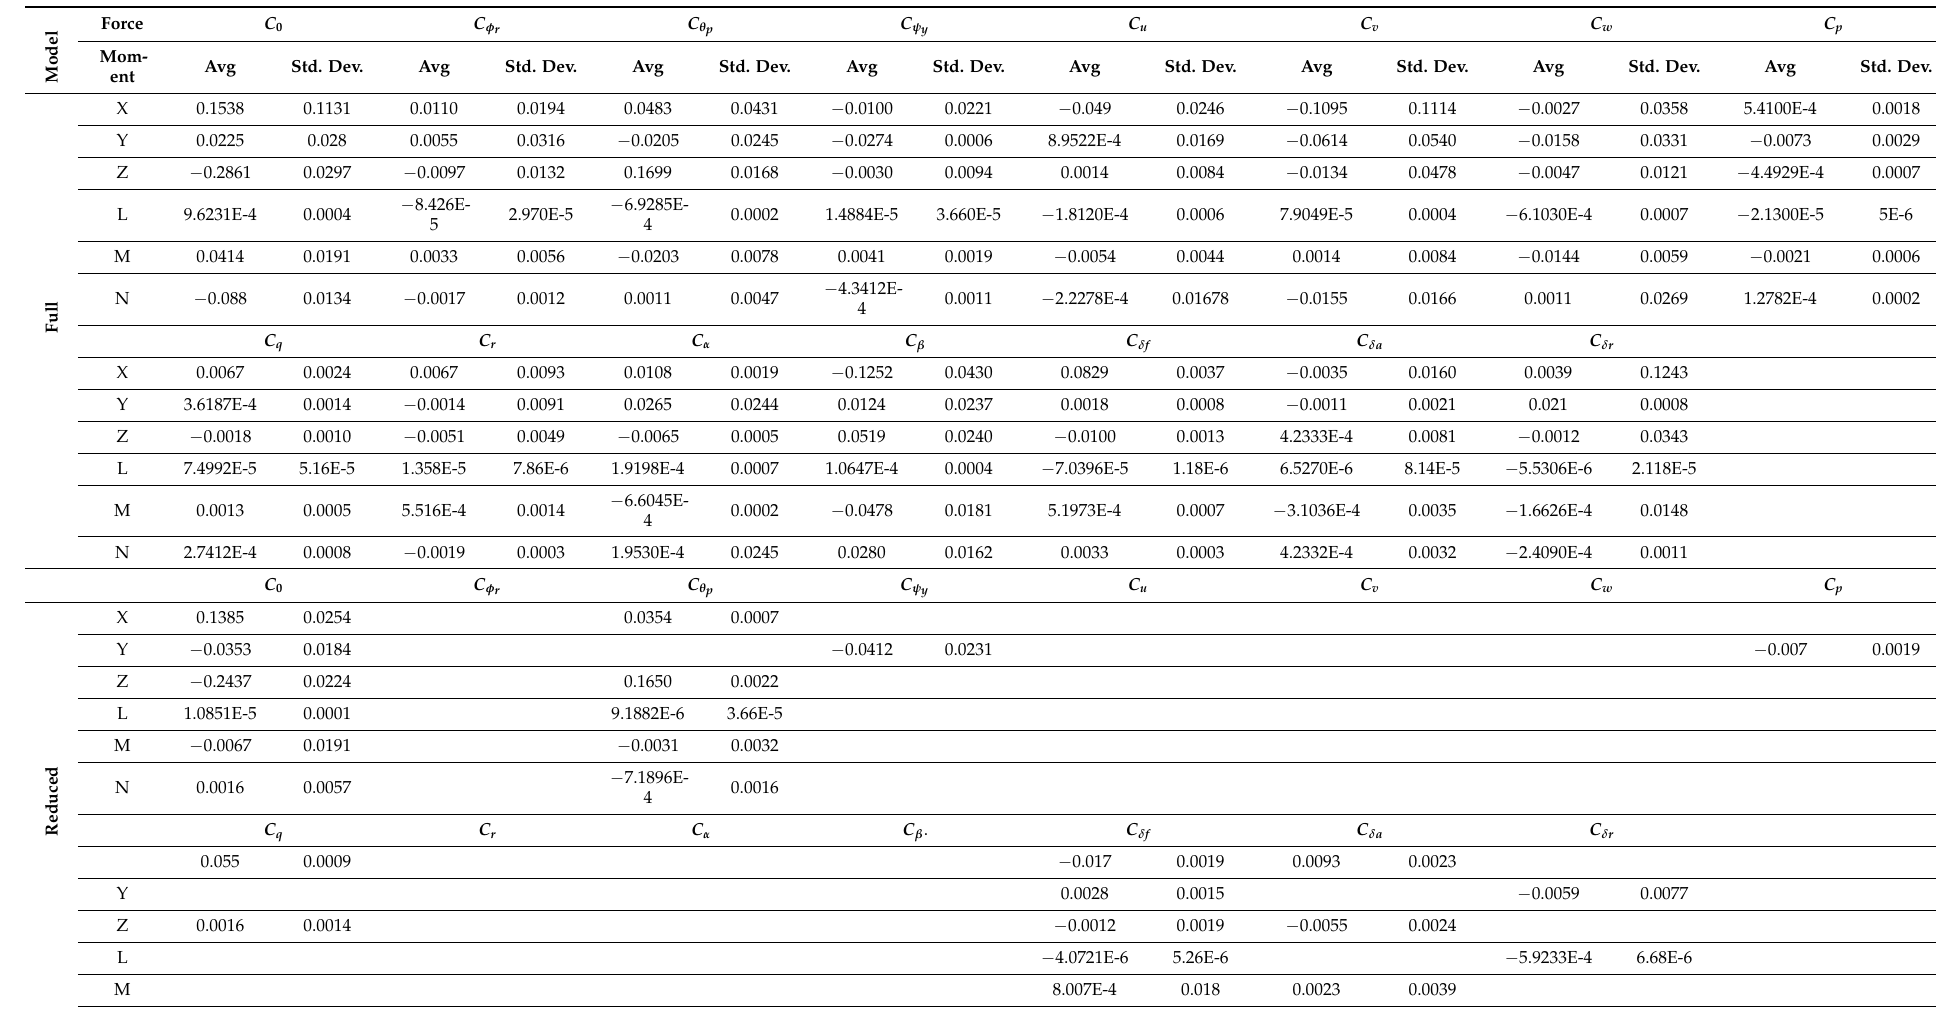
Table 1. Average and standard deviation of the estimated parameters for the full and reduced order models